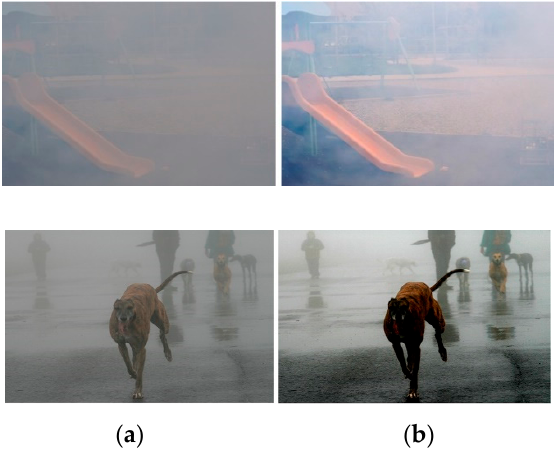
Figure 14. Image enhancement results on challenging cases. The left image is the input and the right image is the output. ( a ) Heavy haze; ( b ) large depth of field.